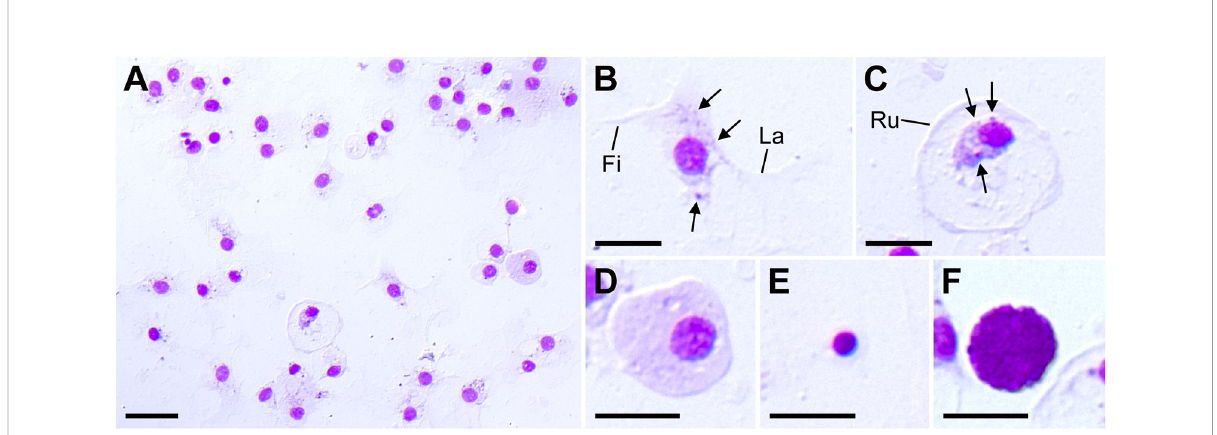
FIGURE 1 Patiria pectinifera coelomocytes. (A) Coelomocytes smear stained by MG. (B – F) Five identi fi ed cell types: (B) amoebocyte; (C) discoidal phagocyte; (D) agranulocyte; (E) progenitor cell; (F) morula cell. Fi, fi lopodia; La, lamellipodia; Ru: membrane ruf fl ing, Arrows: granules. Scale bars: 20 µm (A) , 10 µm (B – F)